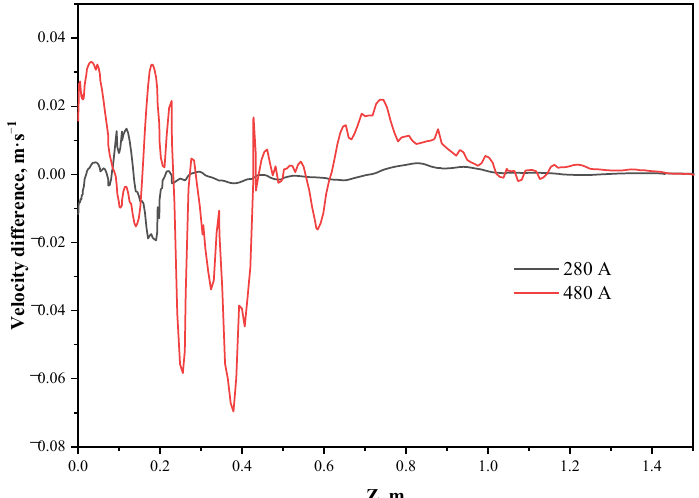
Figure 18. Distribution of the difference in washing velocity at the solidification front on the inner and outer arc sides.